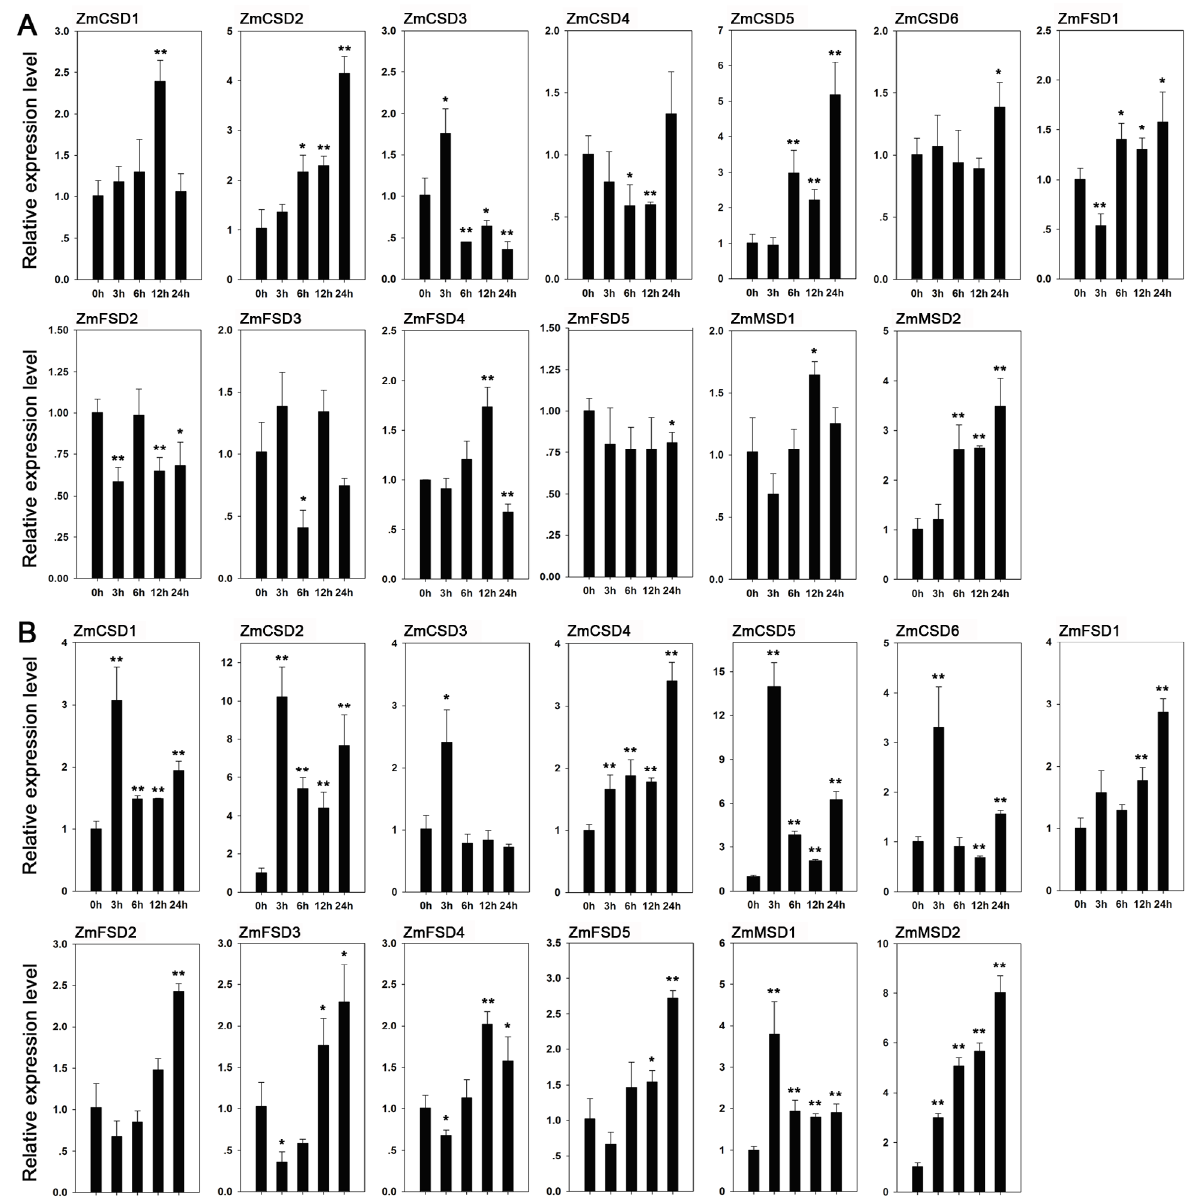
Figure 8 ‒ Expression pattern analysis of ZmSOD genes under drought (A) and salt (B) treatments by qRT-PCR. The X-axis is the time course of treatment, and seedlings were sampled at 0 (CK), 3, 6, 12 and 24 h after drought or salt treatment, respectively. The Y-axis shows the relative expression levels.